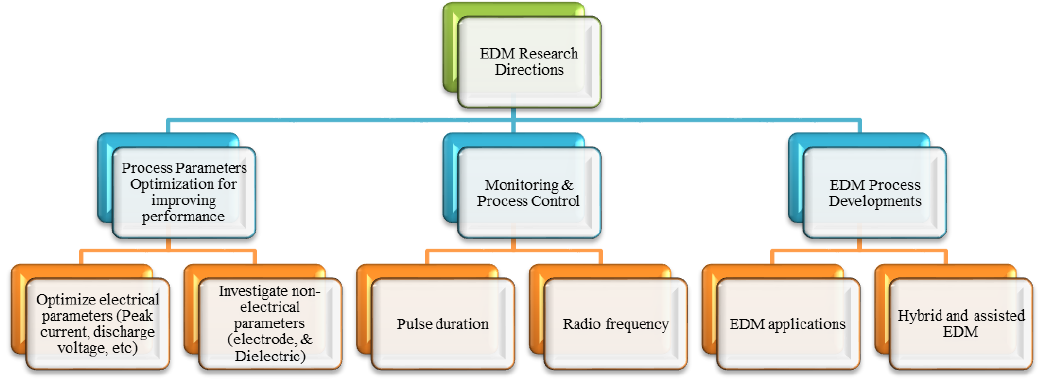
Figure 34. Classification of possible future research directions.